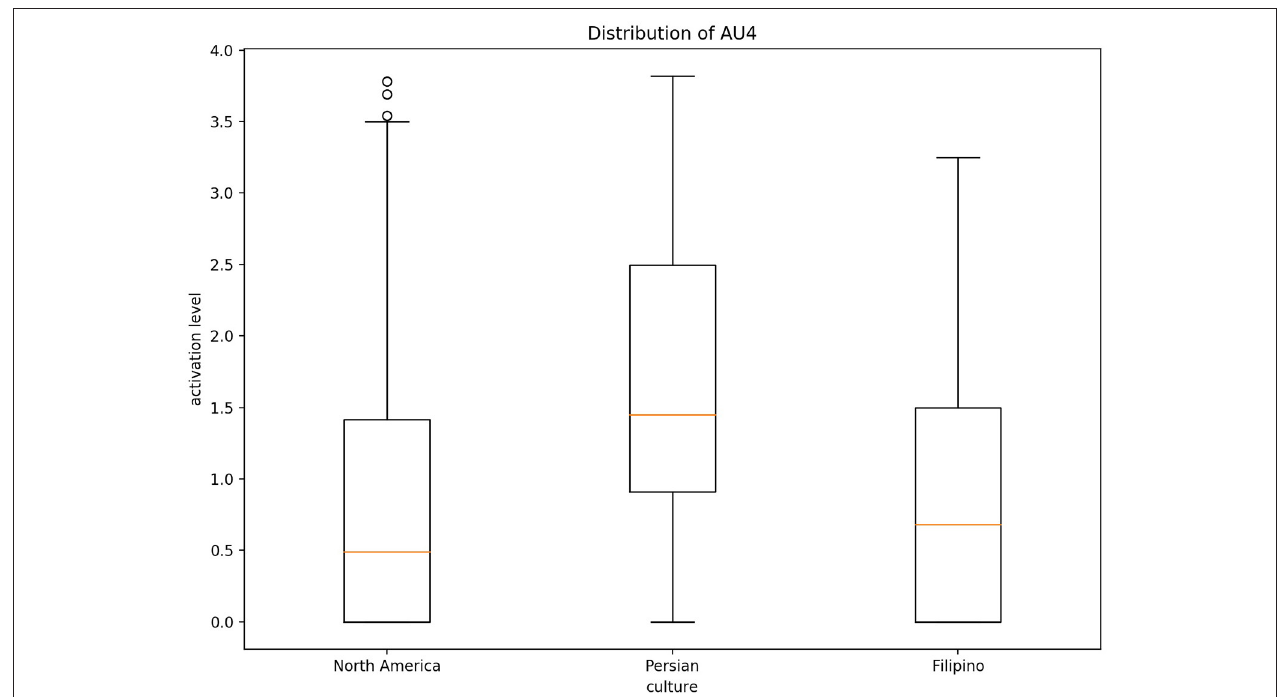
FIGURE 6 | Distribution of AU4 cross-culturally for disgust.